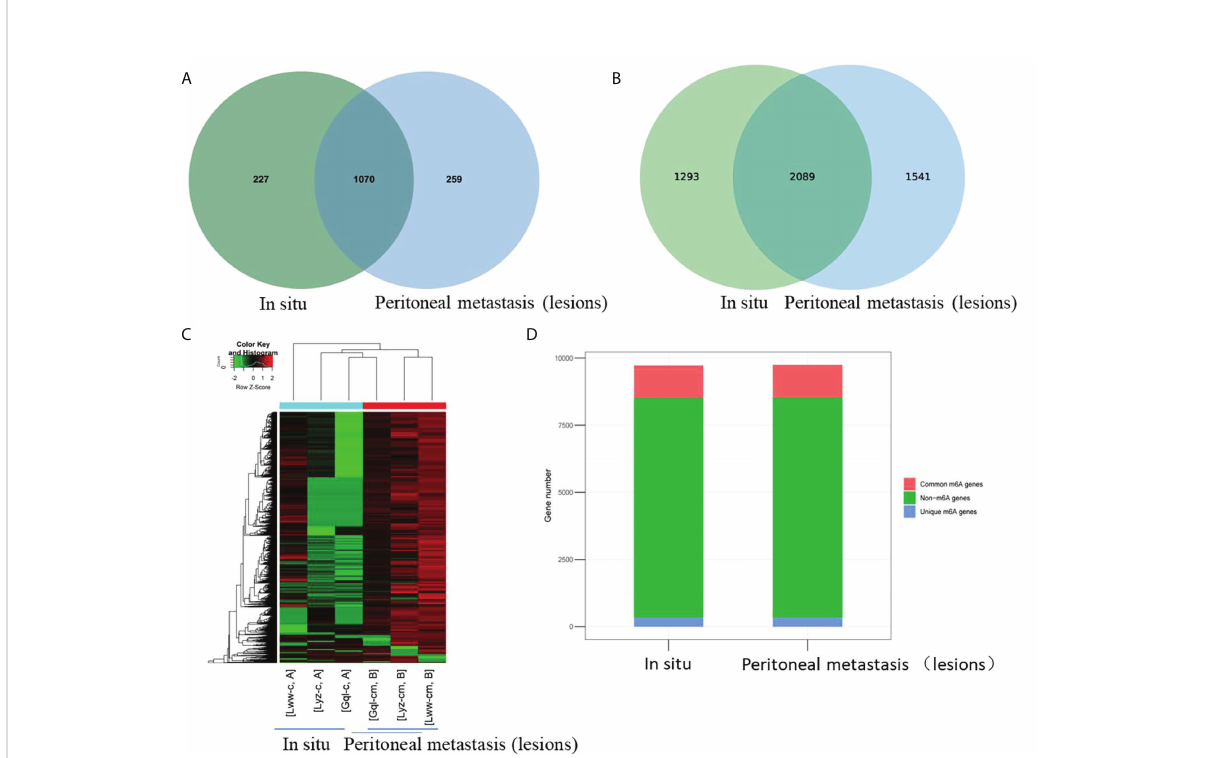
FIGURE 1 Overview of m 6 A-modi fi ed circRNAs of the in situ and the peritoneal metastasis lesions in the HGSCO patients. Vnn diagrams presenting the overlapped (A) m 6 A-modi fi ed circRNAs and (B) m 6 A peaks of the in situ and the peritoneal metastasis lesions in HGSCO patients. (C) Heatmap of the m 6 A-modi fi ed circRNAs. (D) Bar plots of the m 6 A peaks pear circRNAs.